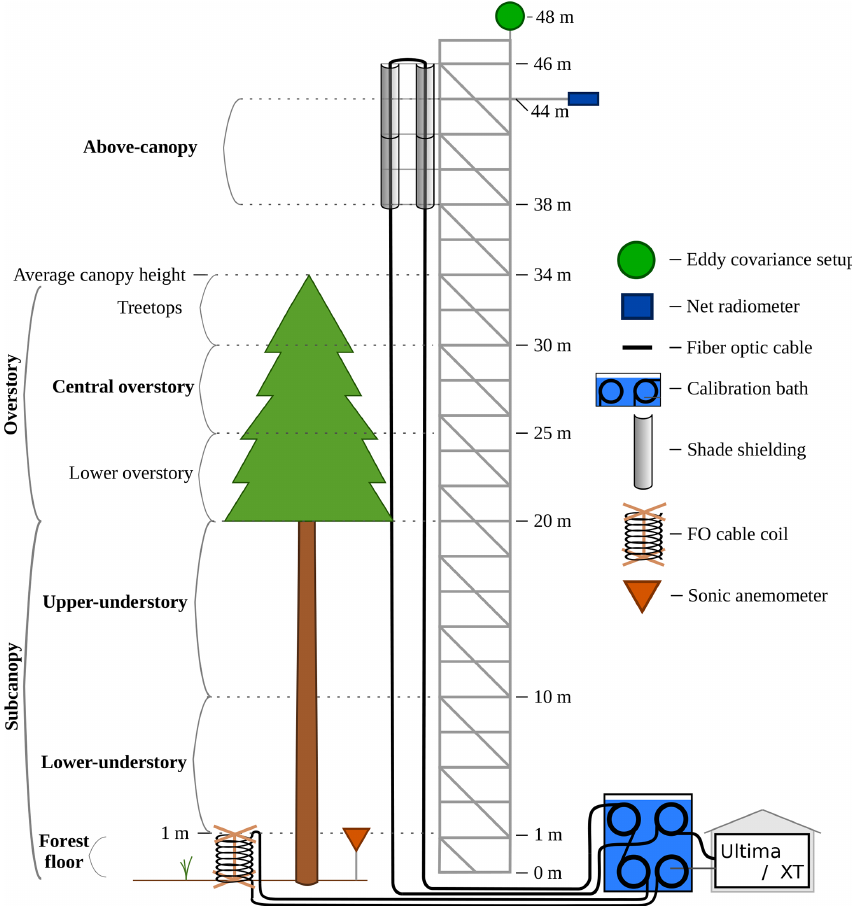
Figure 3. Schematic overview of the measurement setup at the tower. On the left the different sections are shown. There is a gap in the sections from 34 to 38m, as the unshielded DTS data there are not